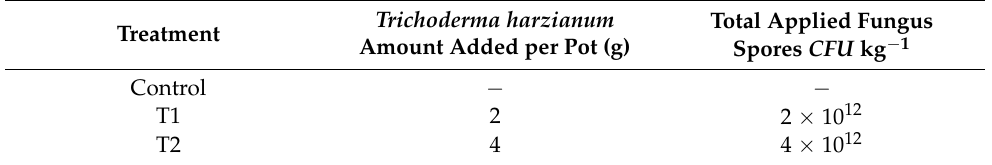
Table 2. Treatments and total Trichoderma harzianum applied